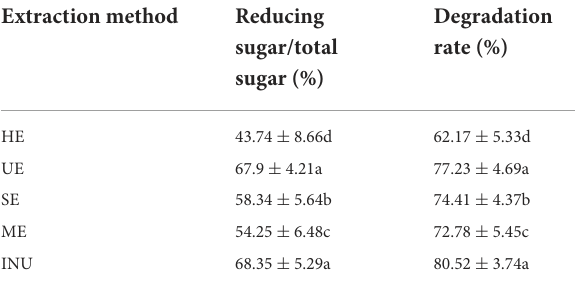
TABLE 2 Analysis of reducing sugar content and degradation rate of in vitro fermentation